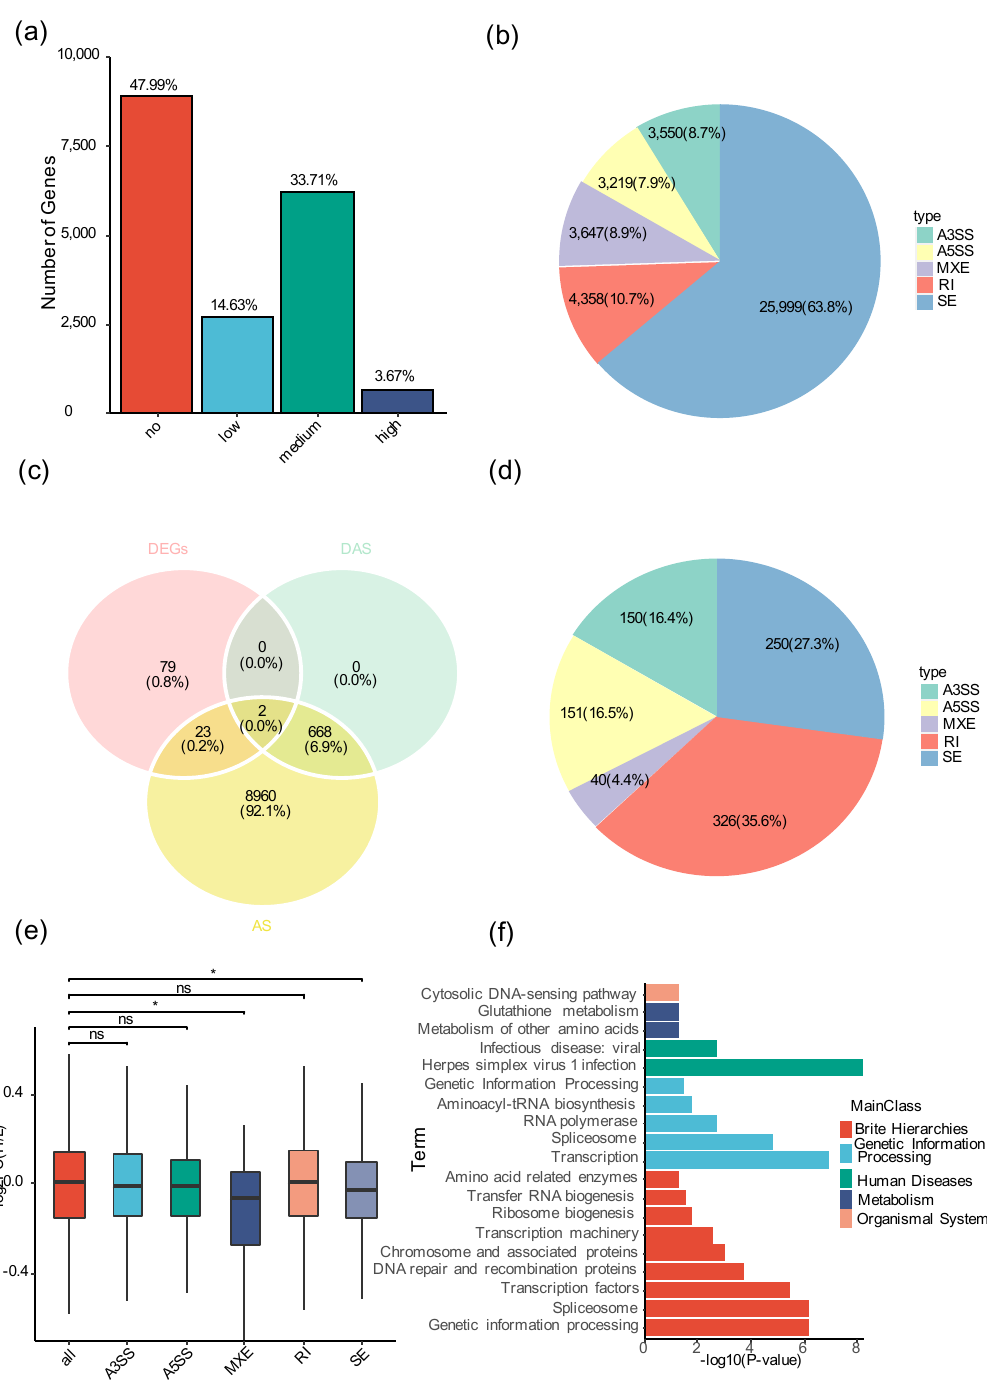
Figure 3. High-altitude stress induced the retained intron type of alternative splicing events in Tibetan sheep ovary. ( a ) Bar plot of all expressed genes classified into four groups: gene expressed but lacking AS events is defined as no, the low-frequency AS gene group was only 1 AS event, the medium-frequency AS gene group was 2 to 10 AS events, the high-frequency AS